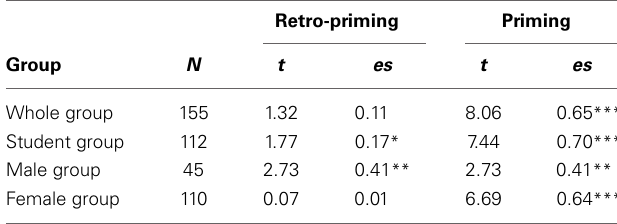
Table 1 | Experiment 1 retro-priming and priming